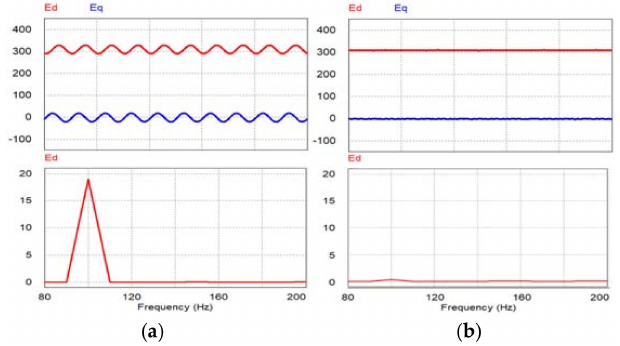
Figure 14. Fast Fourier transform (FFT) analysis result of microgrid inverter. ( a ) Conventional PI controller; ( b ) PI + R